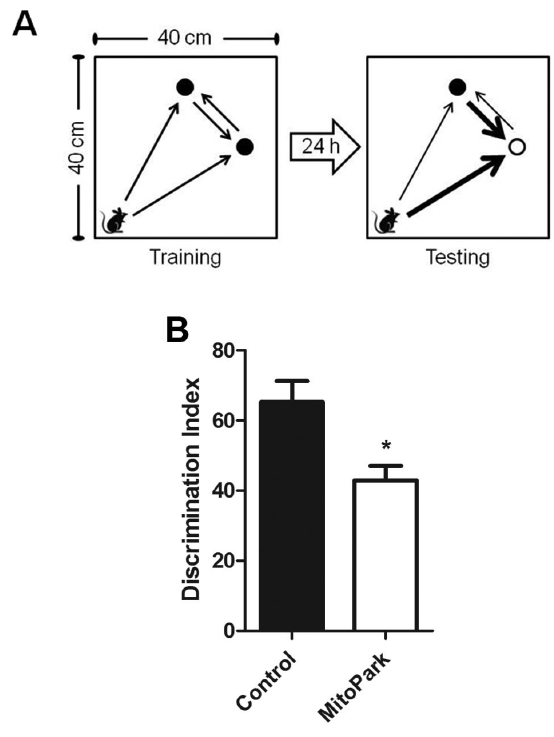
Figure 6. Novel object recognition is impaired in MitoPark mice. (A) A Schematic illustrating the arena setup for both training and testing phases of the task. (B) 24 h after exposure to two identical objects in an open arena, the discrimination index was assessed by measuring the duration of time spent exploring the novel object versus the total time spent exploring both objects was determined. Data represent mean 6 SEM, (n=8 mice/group). *p , 0.01 for MitoPark versus littermate